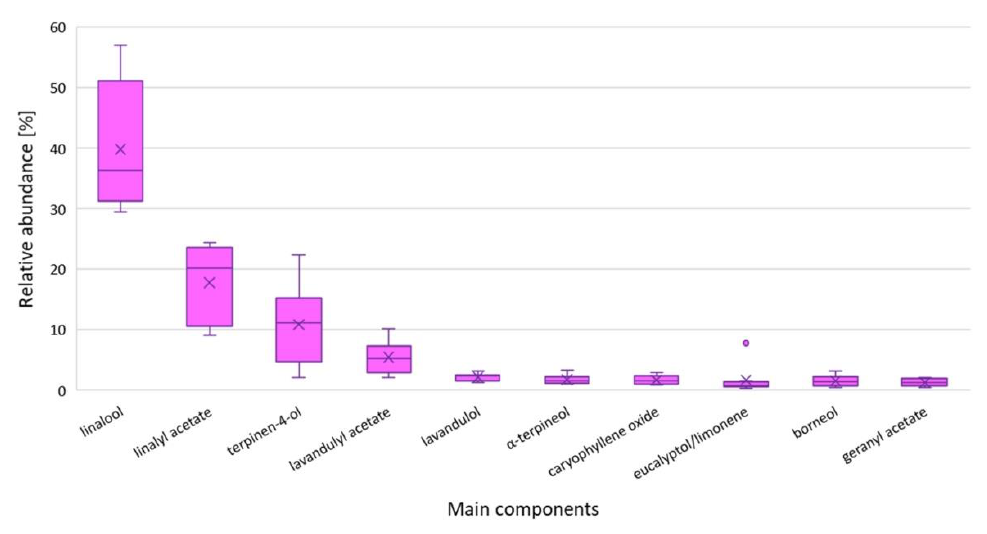
Figure 1. The relative abundances of the main components in the studied L. angustifolia essential oils. The boxes represent the Q1–Q3 interquartile ranges. Lines intersecting the box represent the medians, and crosses represent the average value. Whiskers represent the lowest and highest results. Dots represent outlying results.